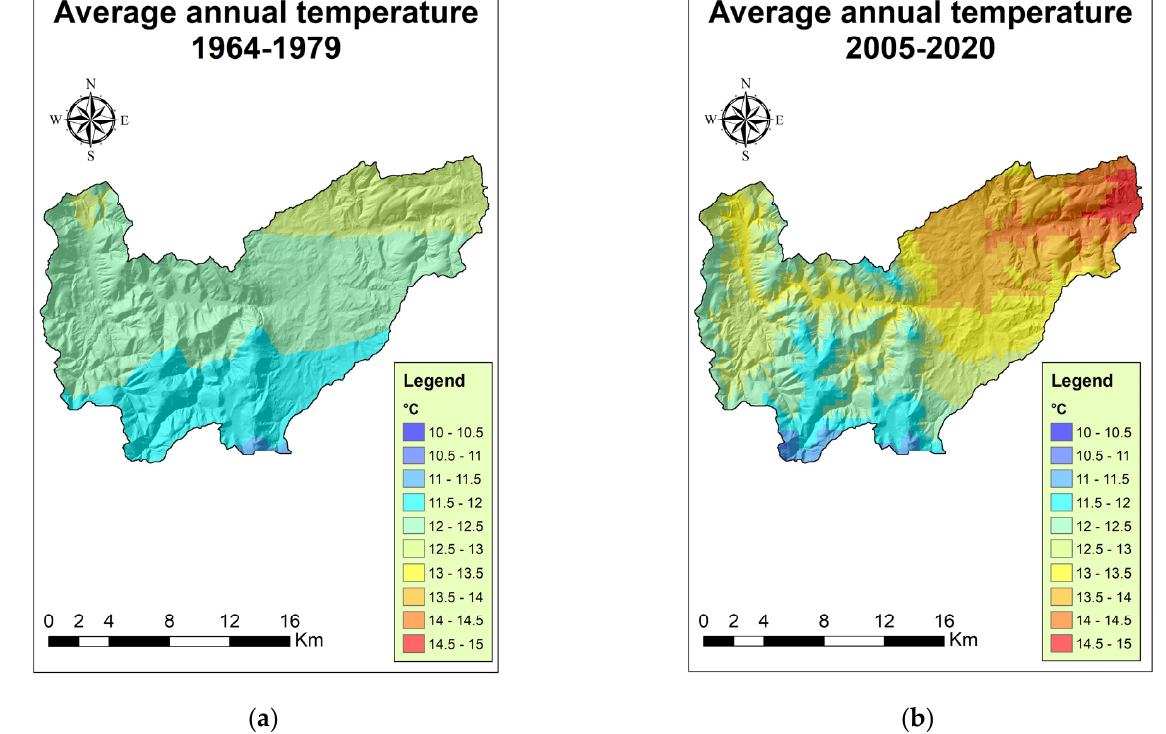
Figure 8. Average annual temperature: ( a ) 1964–1979; ( b ) 2005–2020.